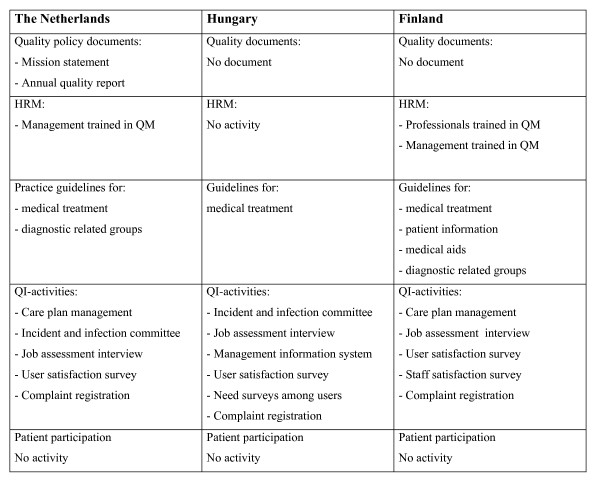
Strong points: QM-activities that 75% of the hospitals of a country has developed